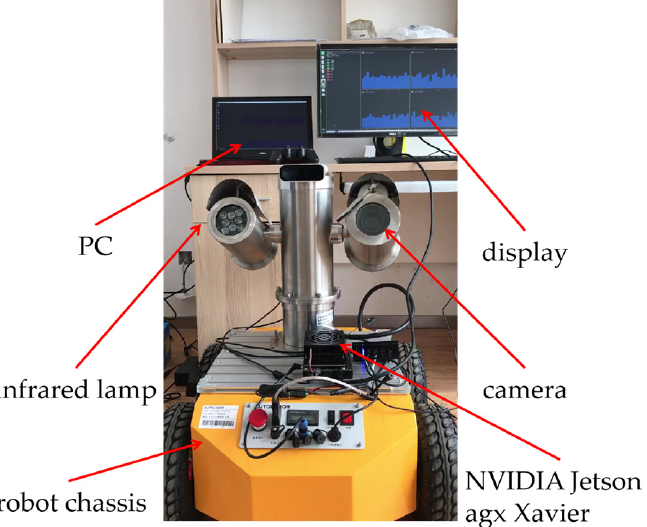
Figure 16. Experimental platform.